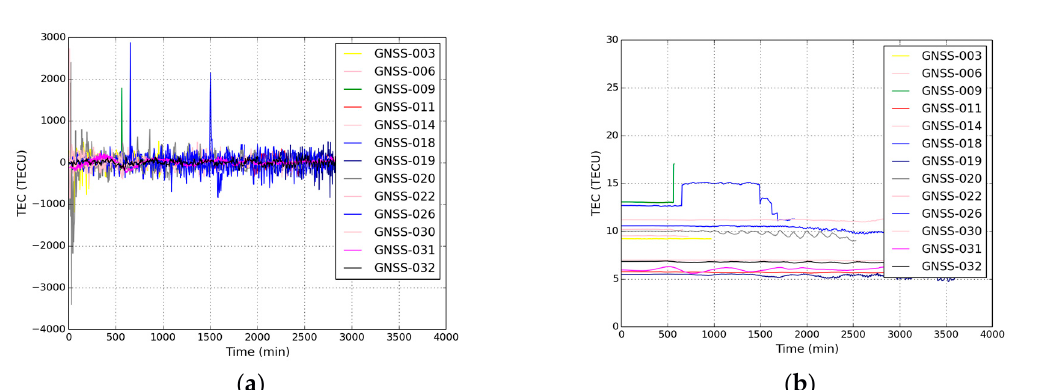
Figure 1. Results of TEC measurements by single-frequency method: ( a ) Before Kalman filtering; ( b ) After Kalman